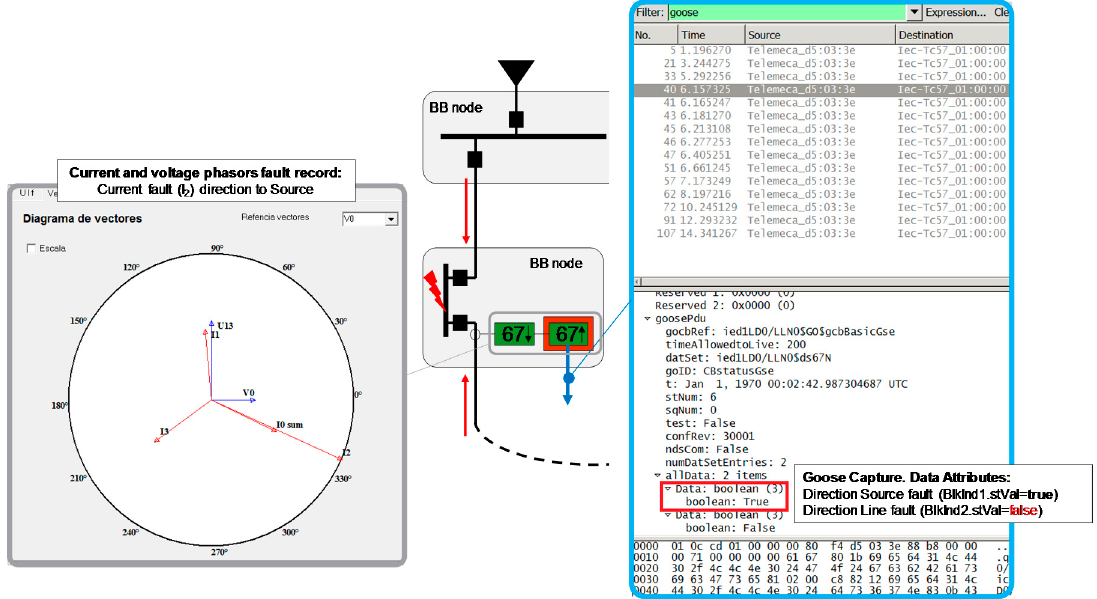
Figure 15. Line direction phase-2 fault.